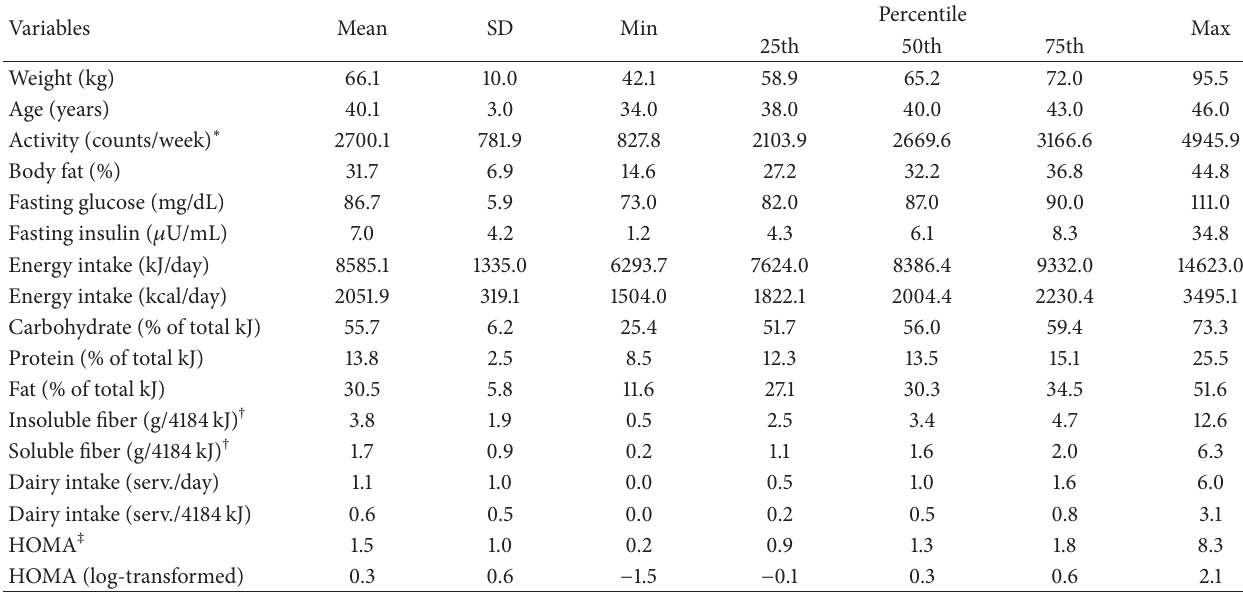
Table 1: Descriptive statistics ( 𝑛 = 272).